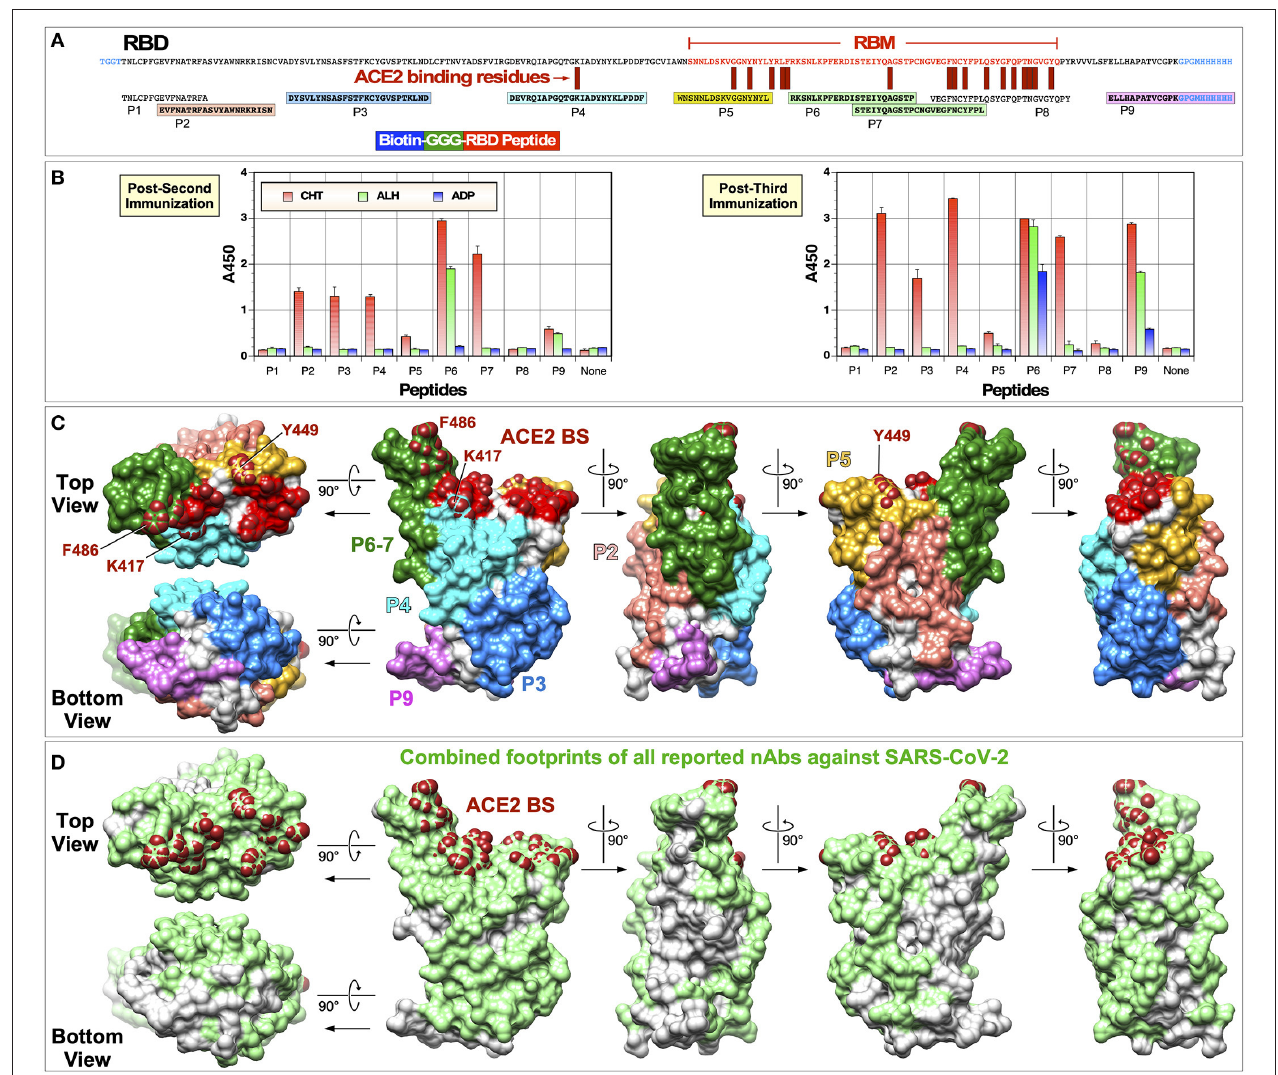
FIGURE 8 | Identification of immunogenic epitopes using biotinylated peptides. (A) Sequences of the RBD and biotinylated peptides used are shown. Amino acid residues located within the RBM are indicated in red text. Immunogenic epitopes are highlighted in colored boxes. (B) ELISA was done using serum samples collected 2 weeks after the second or third immunization (1:300 dilution). ELISA plates were coated with streptavidin (300 ng per well) and 100 ng peptides were attached to streptavidin. Negative controls without any peptides are indicated as “None.” (C) Locations of immunogenic peptides are mapped onto the RBD structure (PDB: 6M0J). (D) Combined footprints of 32 neutralizing mAbs with known crystal structures are shown.